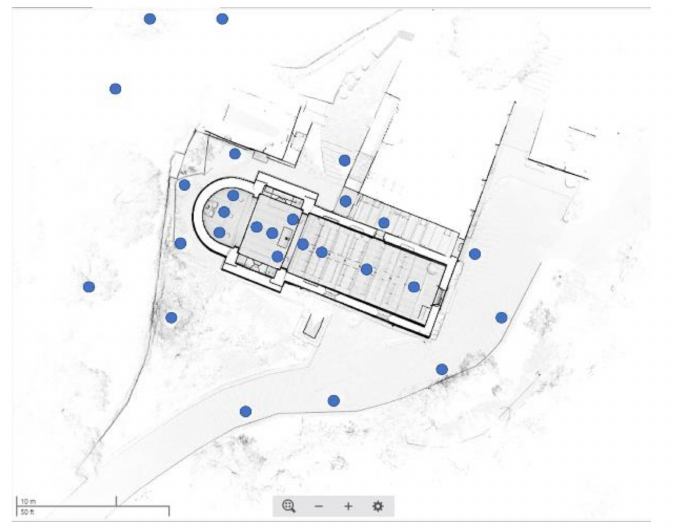
Figure 6. Plan of the church with scan location shown as blue